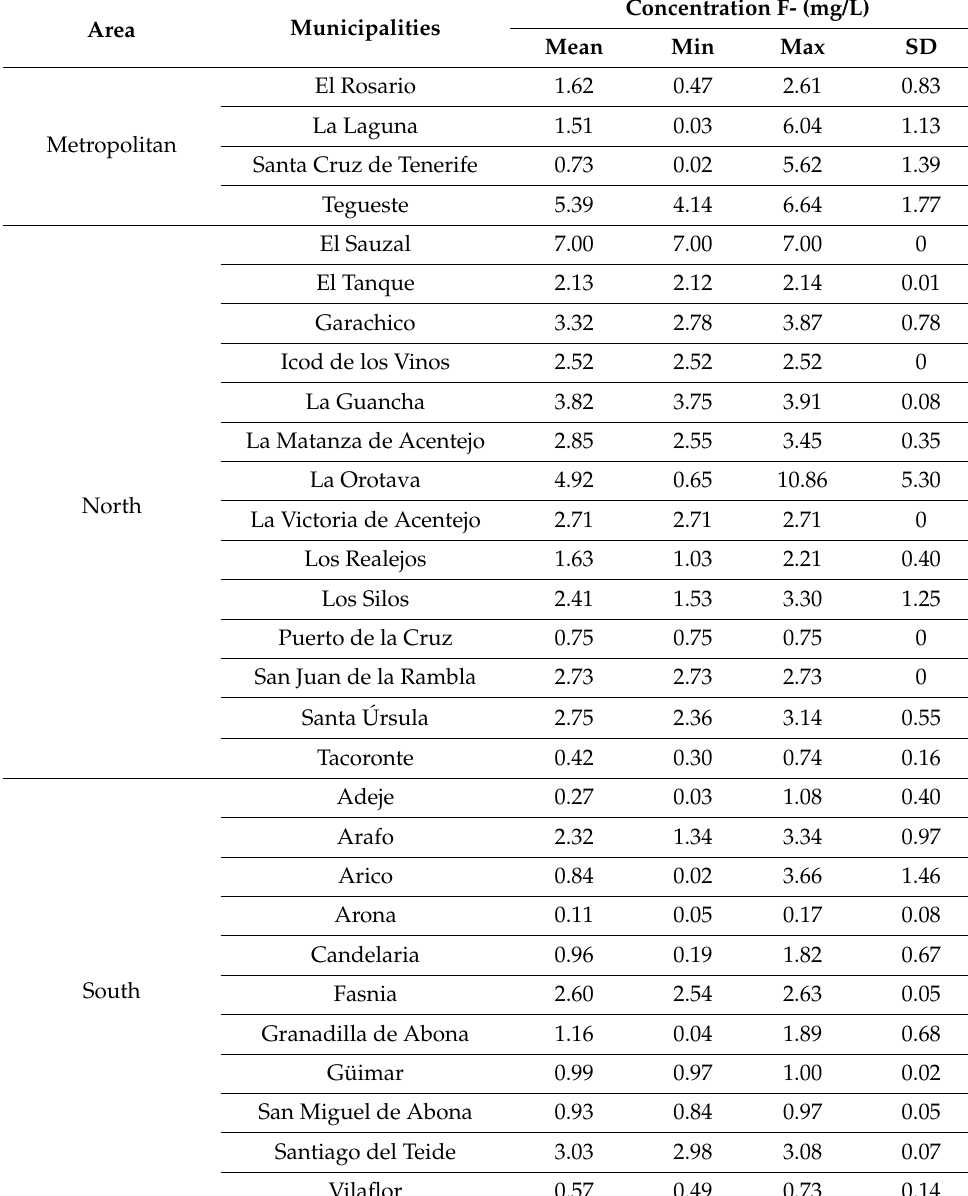
Table 3. Mean concentrations, standard deviations (SD), maximum and minimum values of fluoride in water samples from